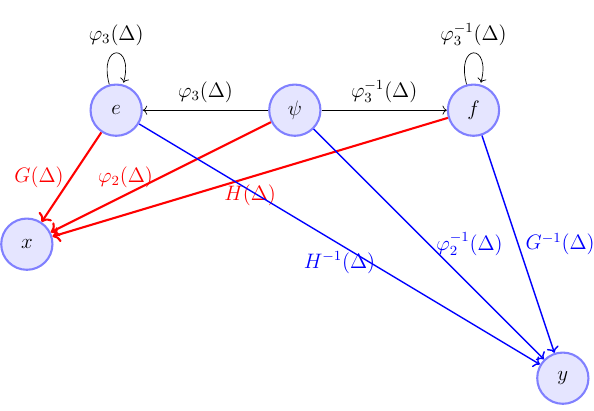
Figure 2 . The OPE relations involving x and y .